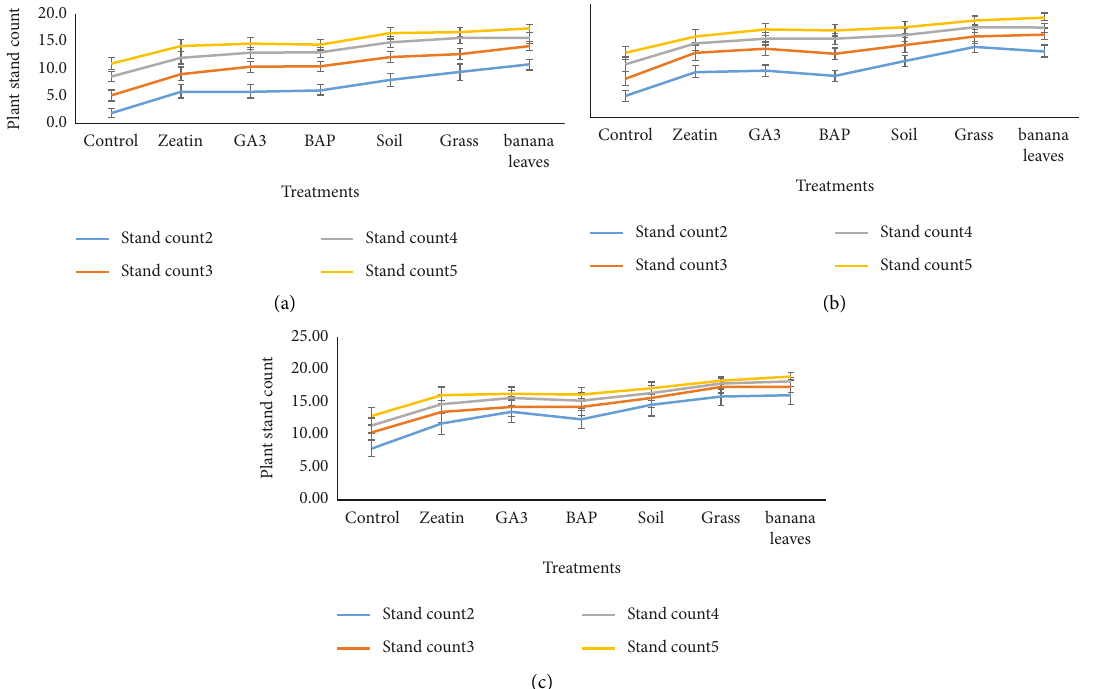
Figure 1: Means and standard error bars of germinated potato varieties (plant stand count) as affected by natural materials (soil, banana leaves, and grass) and plant growth regulators (GA 3 , BAP, and Zeatin). Stand counts 2, 3, 4, and 5 weeks after planting. (a) Dutch Robijn; (b) Kenya Karibu; and (c) Shangi